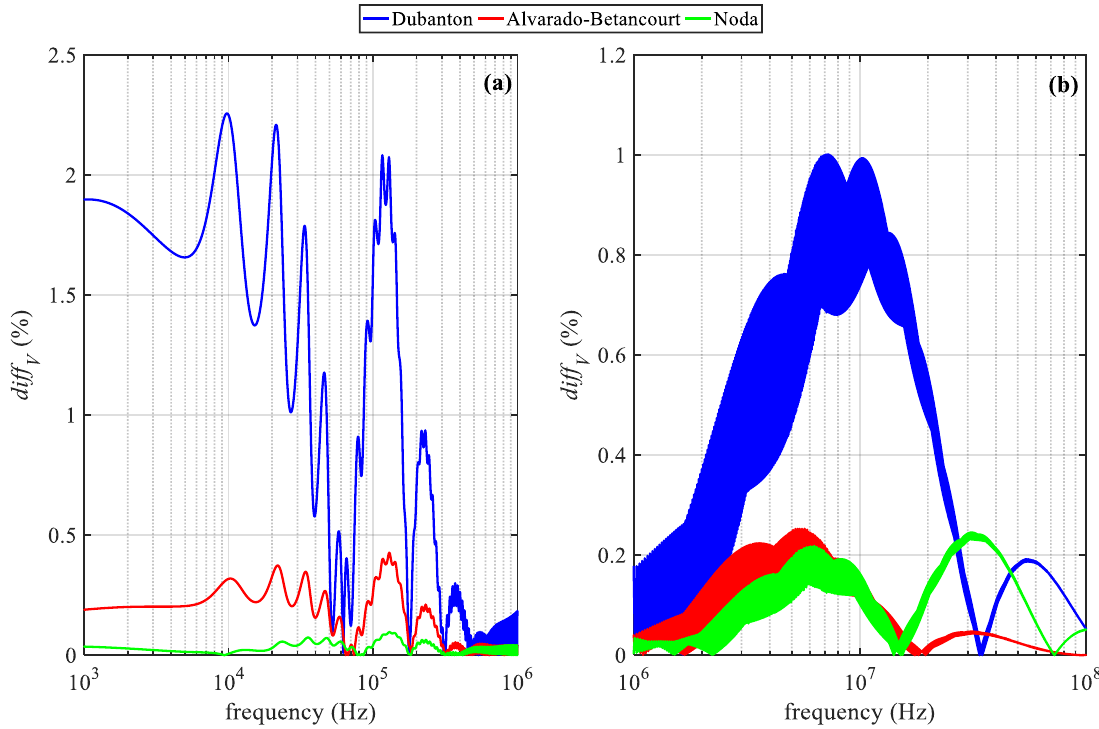
Figure 25. Percentage difference in crosstalk at the receiving end of conductor 2. WTG injection in ( a ) NB and ( b ) BB.